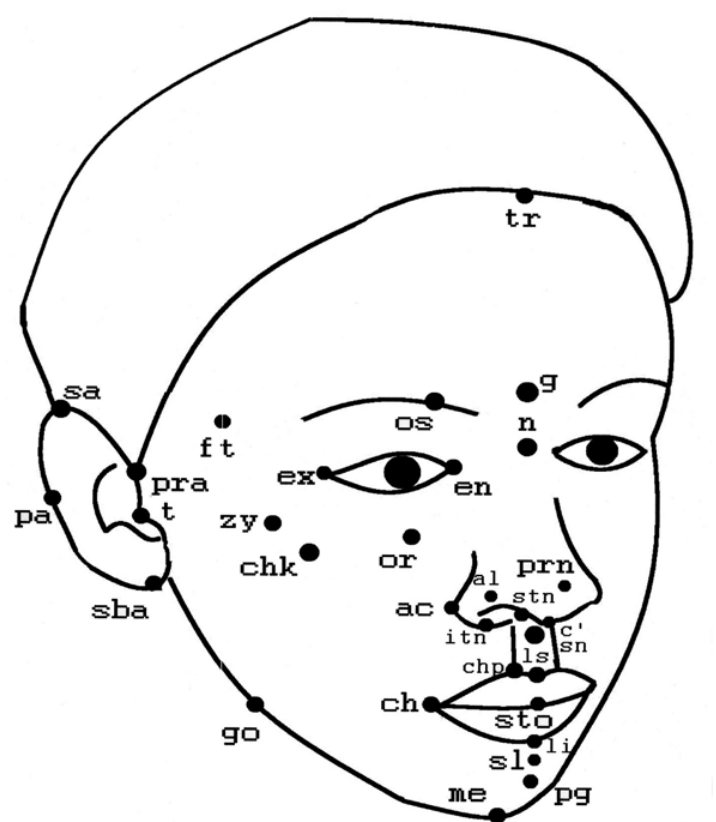
FIGURE 1- Digitized facial landmarks. Midline: tr, trichion; g, glabella; n, nasion; prn, pronasale; c’, columella; sn, subnasale; ls, labiale superius; sto, stomion; li, labiale inferius; sl, sublabiale; pg, pogonion; me, menton. Paired: ex, exocanthion ; en, endocanthion; os, orbitale superius; or, orbitale; ft, frontotemporale; chk, cheek ; zy, zygion; t, tragion; al, alare; ac, nasal alar crest; itn, inferior point of the nostril axis; stn, superior point of the nostril axis; chp, crista philtri; ch, cheilion; go, gonion; pra, preaurale; sa, superaurale; pa, postaurale; sba,